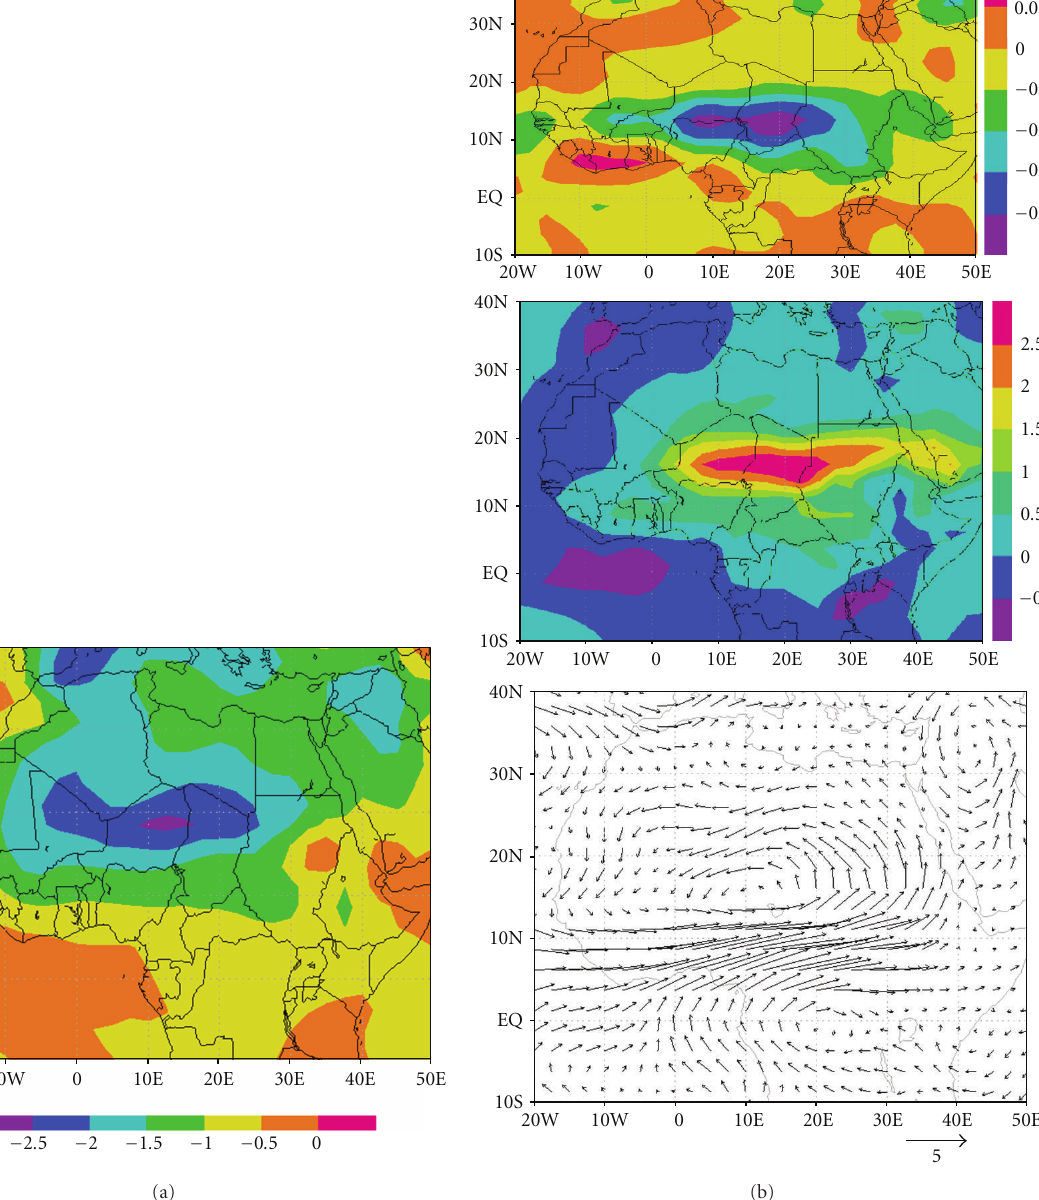
Figure 4: (a) Di ff erence of SLP composites in hPa. Average over 10 years for AZH most westward minus average over 10 years for AZH most eastward. (b) Di ff erences of AZH longitude composites for ω in Pas − 1 (top), specific humidity in gkg − 1 (middle), and horizontal wind field in ms − 1